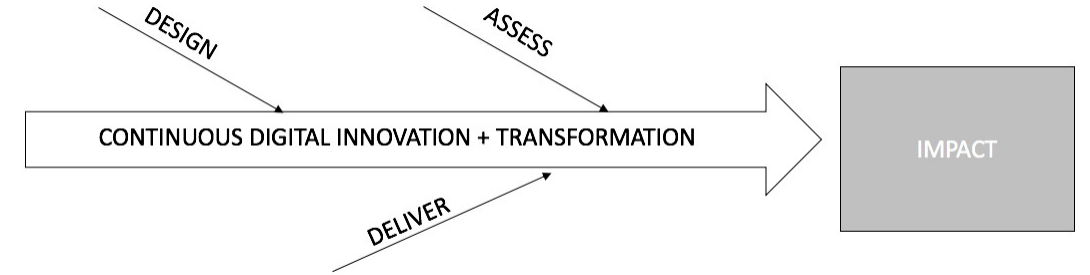
Figure 10. INA-BIM Management Strategy.